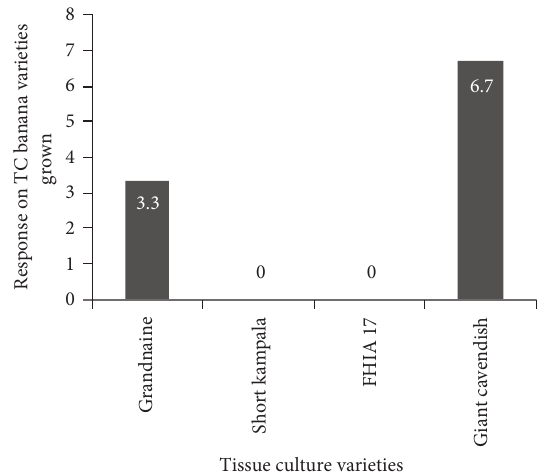
Figure 13: Tissue-cultured banana varieties grown in Kisii County.